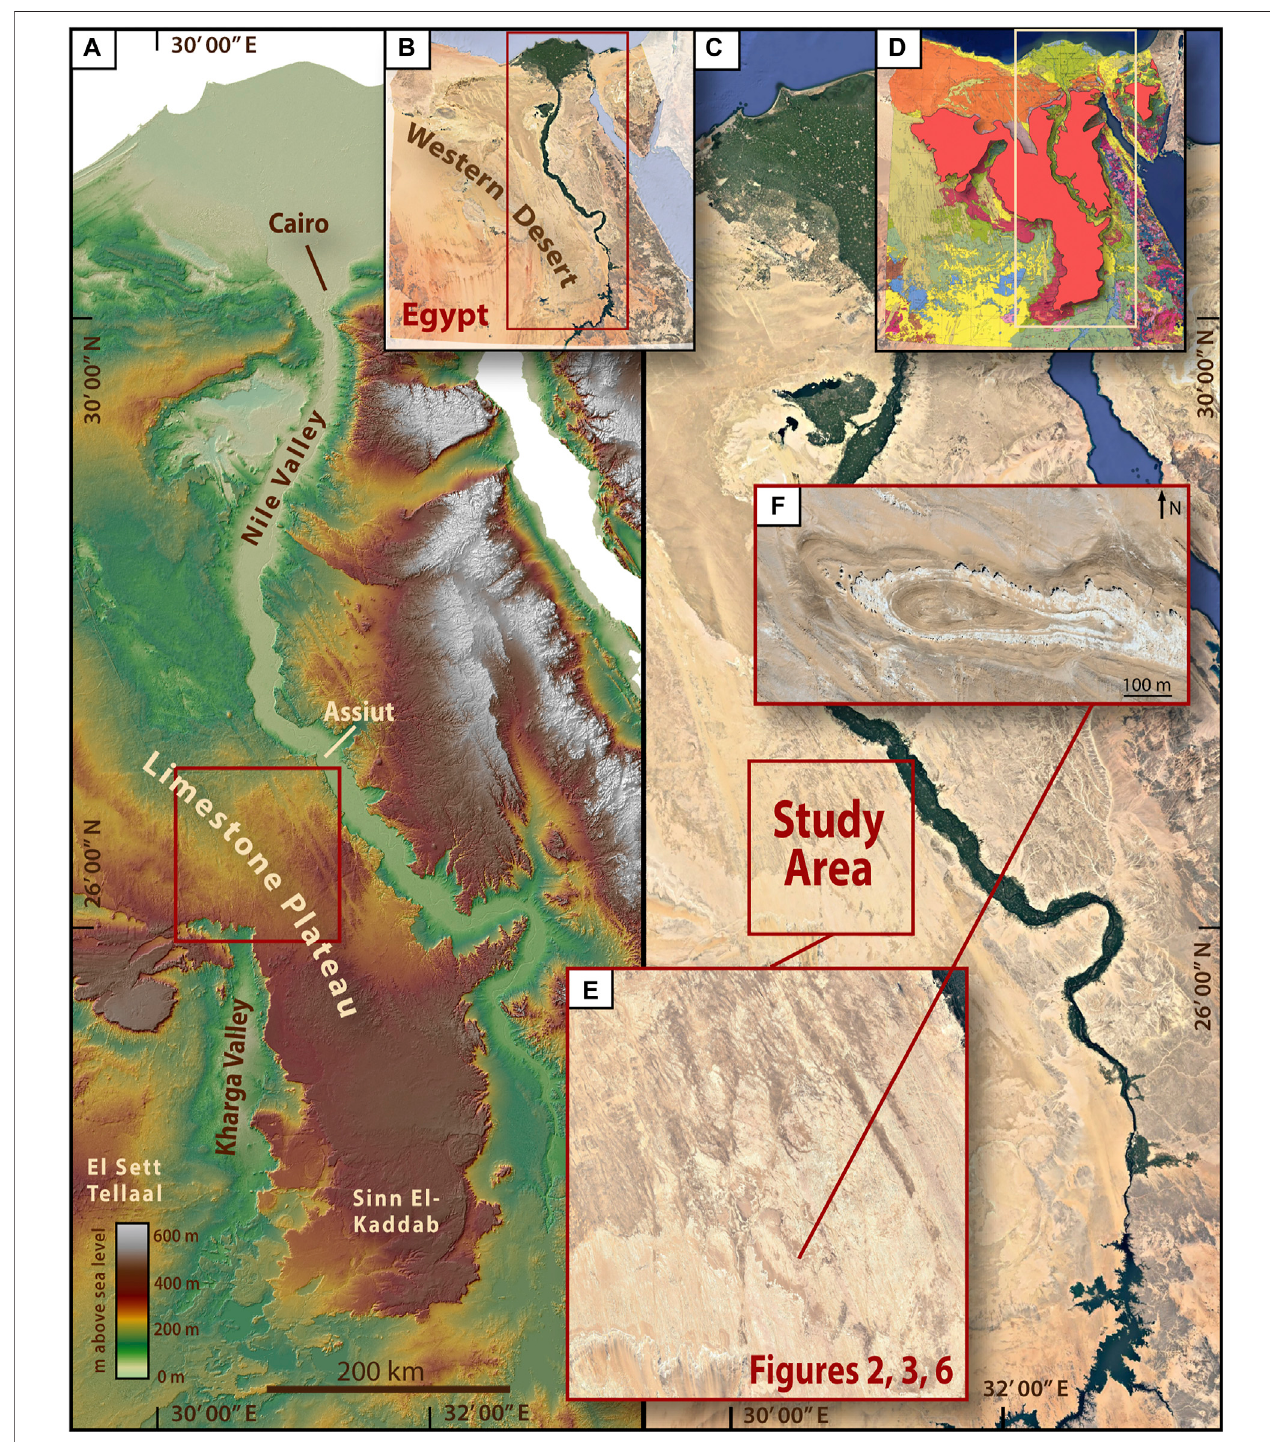
FIGURE 1 | Context maps. (A) Colorized shaded relief map with location of study area (red square) on Limestone Plateau west of Nile Valley. (B) Context map showing Western Desert and location of 1A and 1C (red rectangle). (C) Satellite image of same area as 1A, showing location of study area. (D) Geologic map of Egypt showing outcrop area of Eocene carbonates (dark pink) in Egypt and location of 1A and 1C (tan rectangle). Adapted from EGSMA (1981). (E) Satellite image showing “ wormy ” patterning on the Limestone Plateau in the study area, plus two wide, dark, NNW – SSE stripes co-located with Red Sea Rift-related grabens. (F) Wormy patterningisduetosynclinessuchasthisoneinthelimestonebedrock.Satelliteimagerysource:GoogleEarth.Elevationmodeldatasource:ShuttleRadarTopography Mission (SRTM) digital elevation data. Coordinates for Google Earth images: E) 26.525270, 30.771237; F) 26.263030, 30.895574. Note: Supplementary Figure S1 shows all image locations in map view.